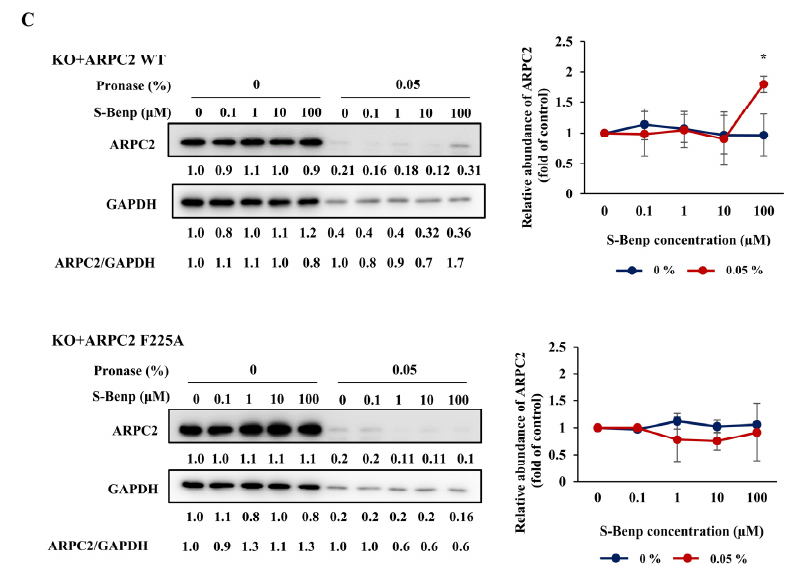
Figure 5. Identification of S-Benp binding sites using ARPC2-mutated cells. ( A ) Transwell migration assay of ARPC2 − / − cells stably transfected with ARPC2 WT or ARPC2 F225A and treated with S- benproperine (S-Benp) for 18 h. The migrated cells were counted using the Image-ProPlus 5.0 program. ( B ) Immunoblotting of ARPC2 and GAPDH followed by incubation with S-Benp and ARPC2 WT or F225A cells after protein denaturation by heat. ( C ) DARTS after incubation with S-Benp and lysates of ARPC2 WT or F225A cells. The graph shows the quantification of the ARPC2 intensity with normalization against GAPDH (nontarget protein). The data represent means ± s.d.; comparisons were performed with t tests (two groups); * p <